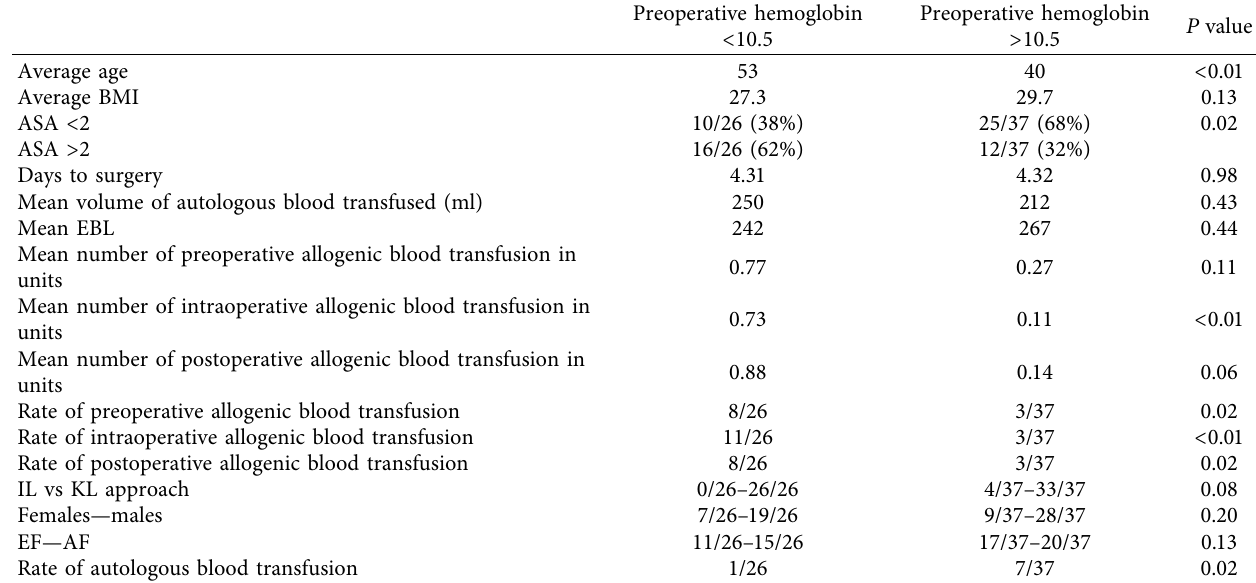
Table 4: Preoperative hemoglobin < 10.5mg/dl was associated with older age, ASA > 2, and higher volume of blood transfused. Risk of preop, intraop, and postop allogenic blood transfusion was higher in patients with preoperative hemoglobin less than 10.5mg/dl. Rate of au- tologous blood transfusion was less in patients with preoperative hemoglobin less than 10.5mg/dl. IL � Ilioinguinal, KL � Kocher-Lan- genbeck, ASA � American Society of Anesthesiology Score, BMI � body mass index, EBL � estimated blood loss, EF–elementary fracture pattern, AF � associated fracture pattern.